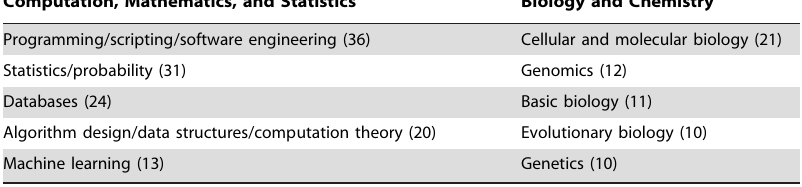
Computation, Mathematics, and Statistics Biology and Chemistry Programming/scripting/software engineering (36) Cellular and molecular biology (21)